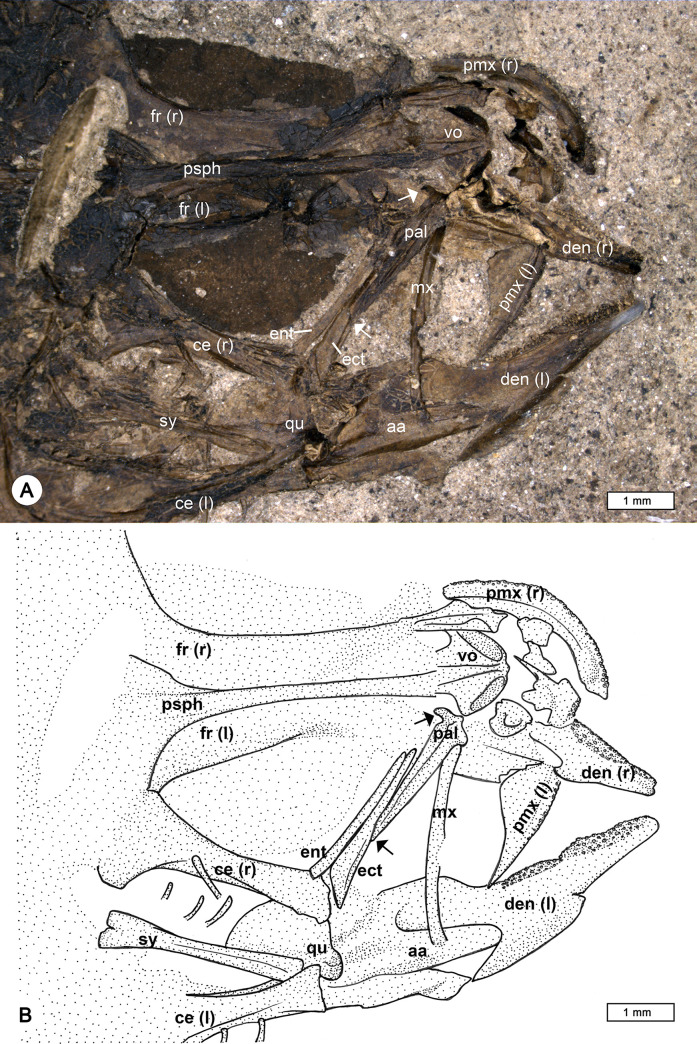
Details of the head and jaw bones of †Pirskenius diatomaceus Obrhelová, 1961.(A, B) Photo and reconstruction of specimen Pv 11669 (ventrolateral view) exposing bones of right (r) and left (l) side, with palatine (pal), ectopterygoid (ect) and entopterygoid (ent) preserved in anatomical connection. Upper arrow indicates ethmoid process of palatine, lower arrow points to ventral tip of palatine. Further abbreviations: aa, angulo-articular; ce, ceratohyal; den, dentary; fr, frontal; mx, maxilla; pmx, premaxilla; psph, parasphenoid; qu, quadrate; sy, symplectic; vo, vomer.